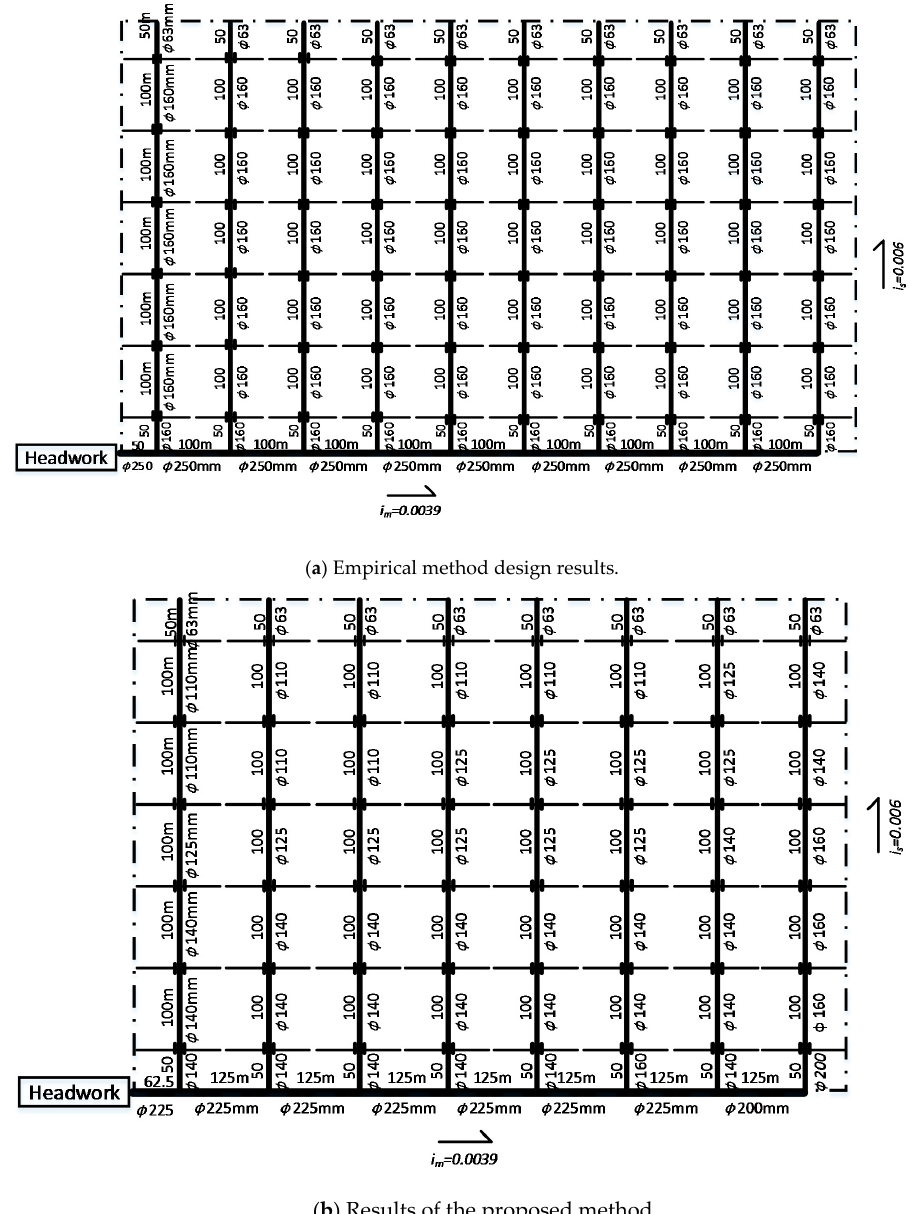
Figure 9. Design results with the ( a ) empirical and ( b ) proposed methods.